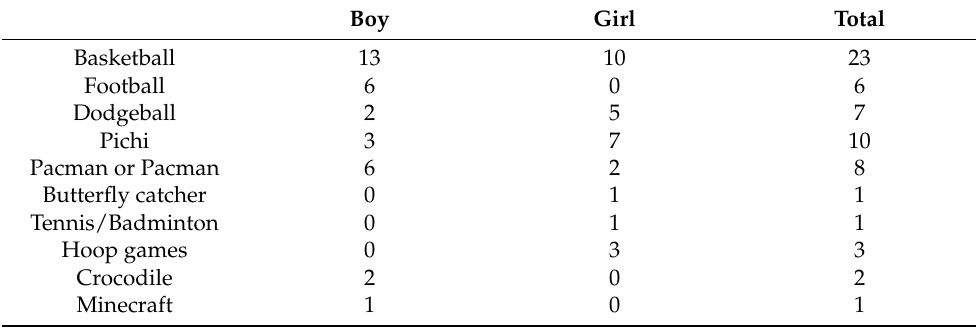
Table 3. Games and sports represented by